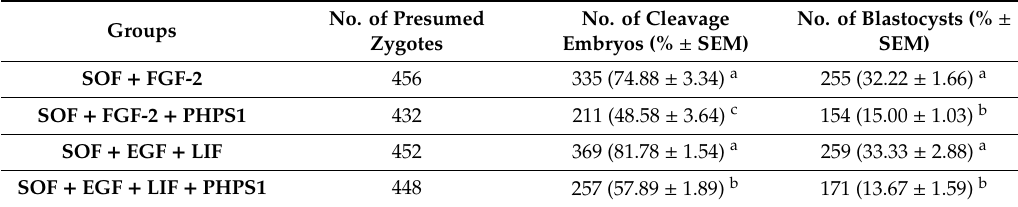
Table 4. Leukemia inhibitory factor and fibroblast growth factor 2 cleavage percentage reversed by